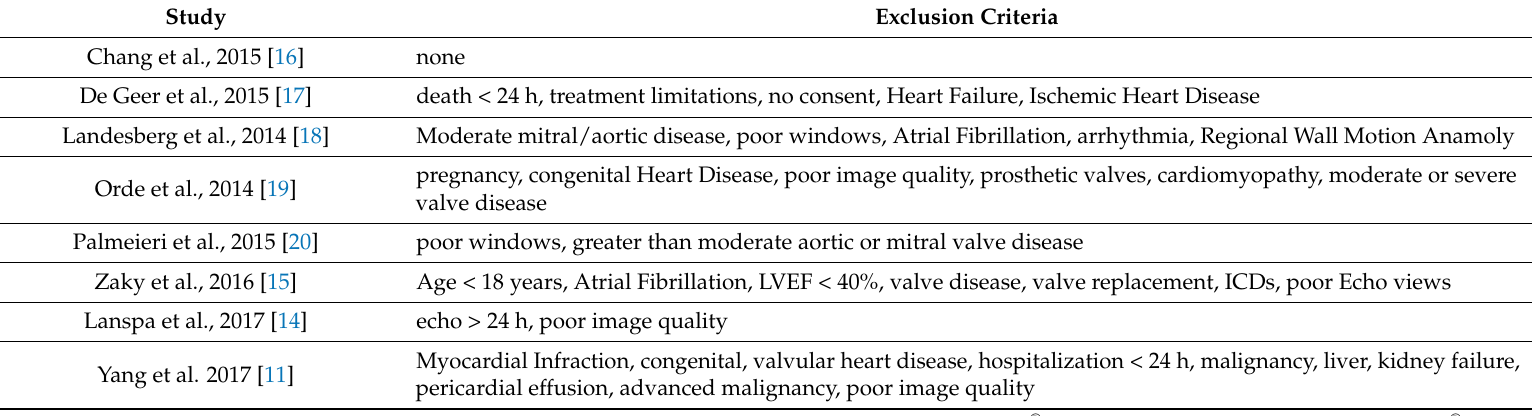
Table 2. Exclusion